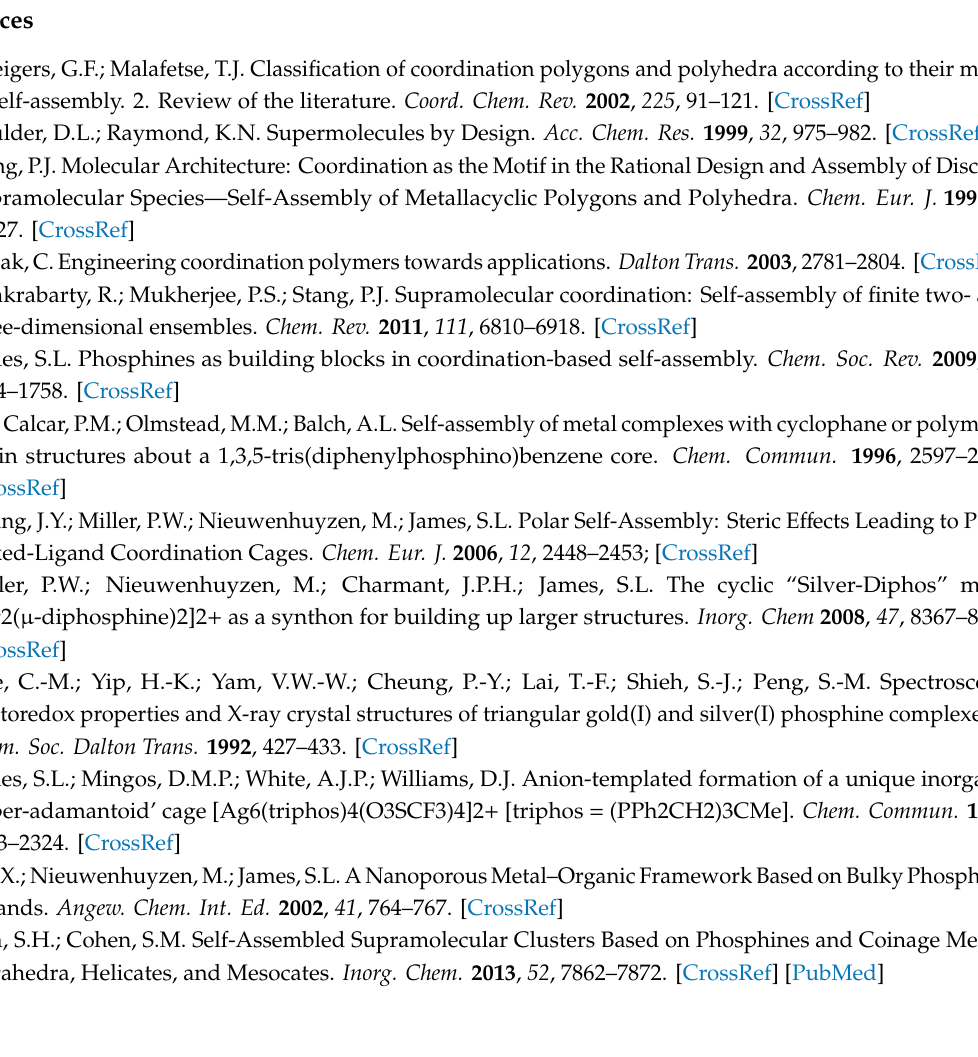
Figure S41: MS (ESI) of 6a , Table S1–S2: X-Ray Structural Data of new